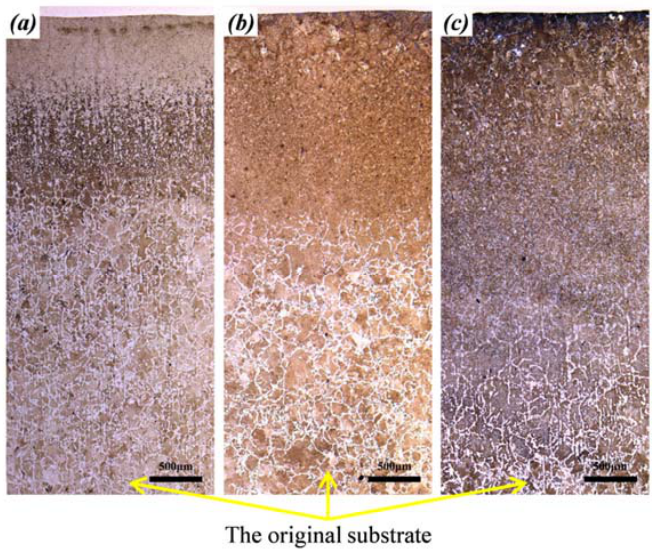
Figure 8. Macroscopic views of the HAZ at 5 kW: ( a ) 300 mm/min, ( b ) 200 mm/min, and ( c ) 100